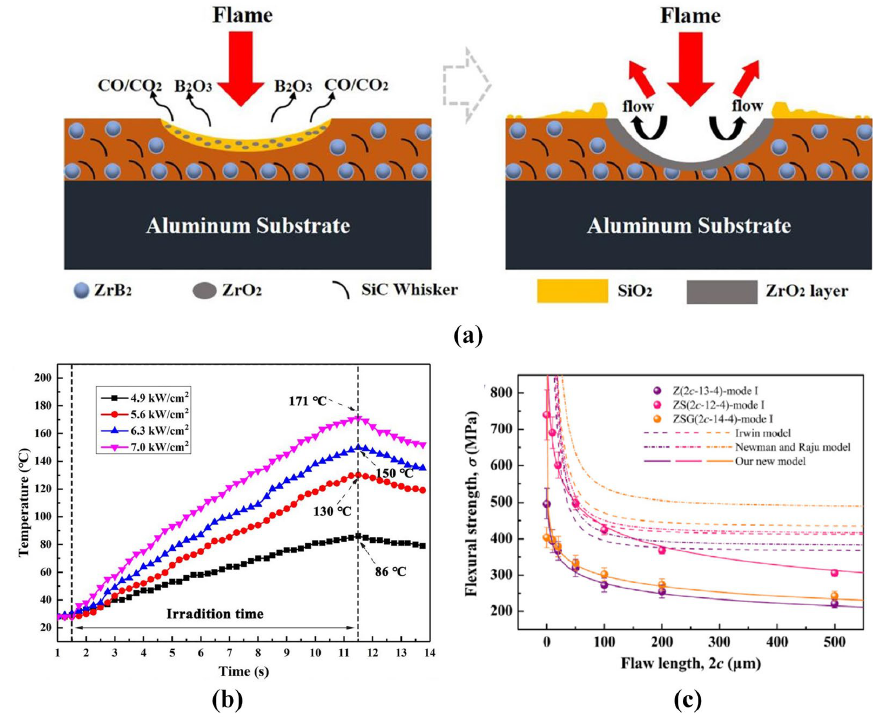
Figure 3. Analysis and schematic diagram of laser machining for boride-based UHTCMCs. ( a ) Laser ablation of composite coating schematic diagram; ( b ) temperature of the back surface substrate at various laser power densities. Reprinted/adapted with permission from Ref. [90]. Copyright 2021, Elsevier. ( c ) Relationship between bending strength and defect length of three ceramics. Reprinted/adapted with permission from Ref. [92]. Copyright 2020, Elsevier. Lonné et al. [93] irradiated the porous composite ZrB 2 of 39 vol.% SiC with a 90 W